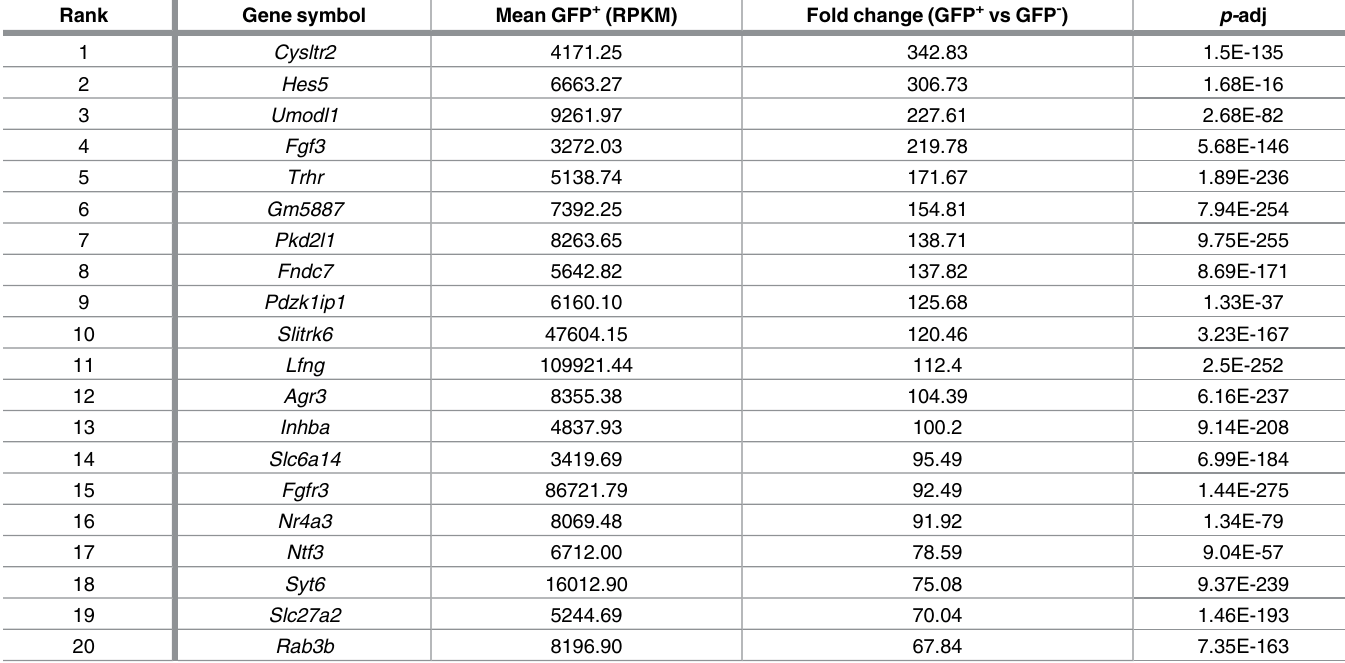
Table 1. Top 20 genes enriched in Lfng-GFP + cells at P1.